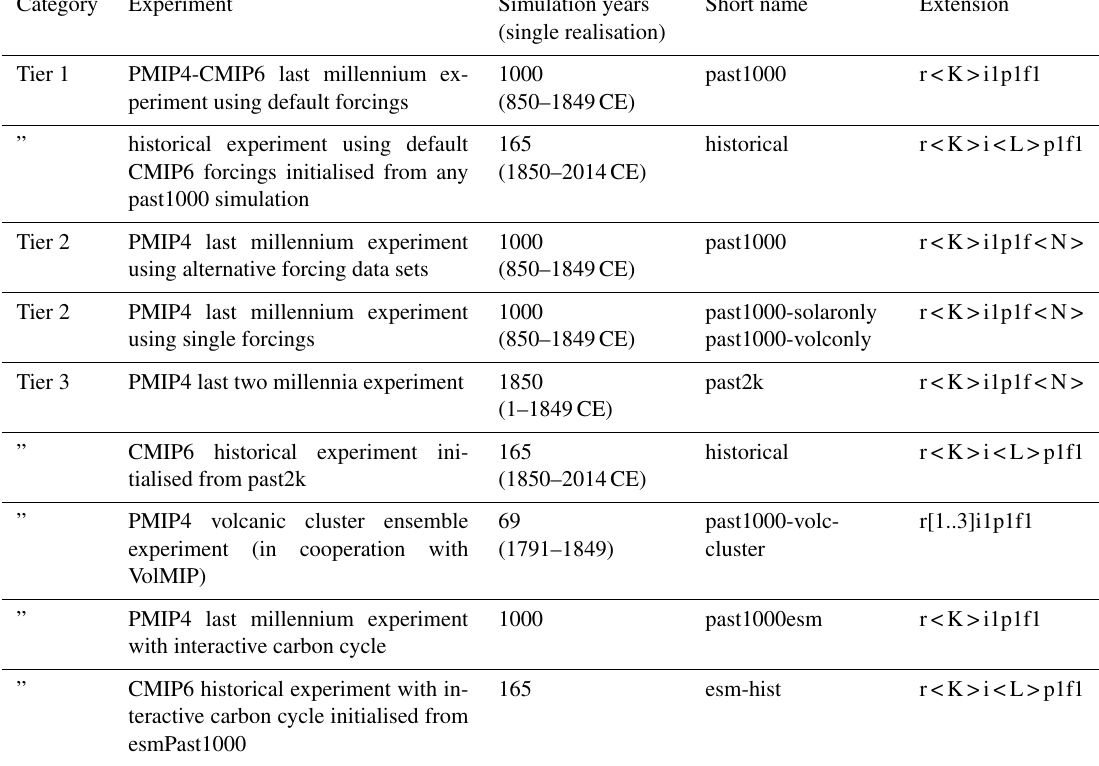
Table 1. List of experiments. In the right column the extension defines the ensemble member by the quad K, L, M, and N of integer indices for “realisation” (r), “initialisation” (i), “perturbed physics” (p), and “forcing (f). Modelling groups need to document the choices, in particular for initialisation and forcing. Note that “f1” should be reserved for the default PMIP4-CMIP6